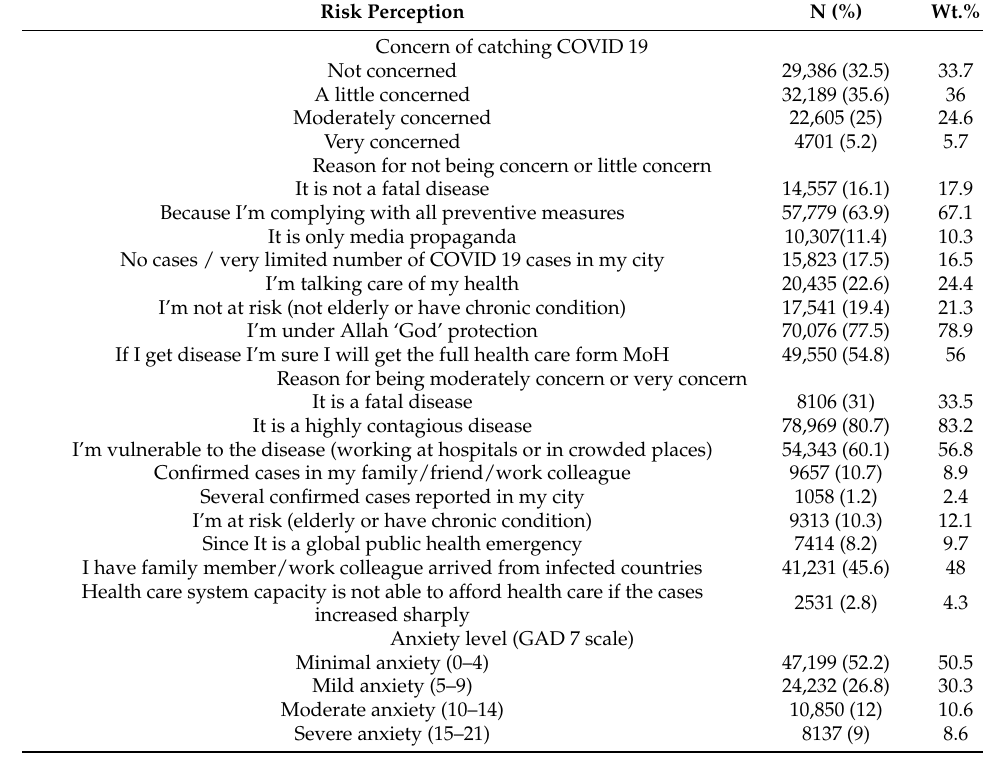
Table 4. Public concern and anxiety about COVID-19 pandemic.